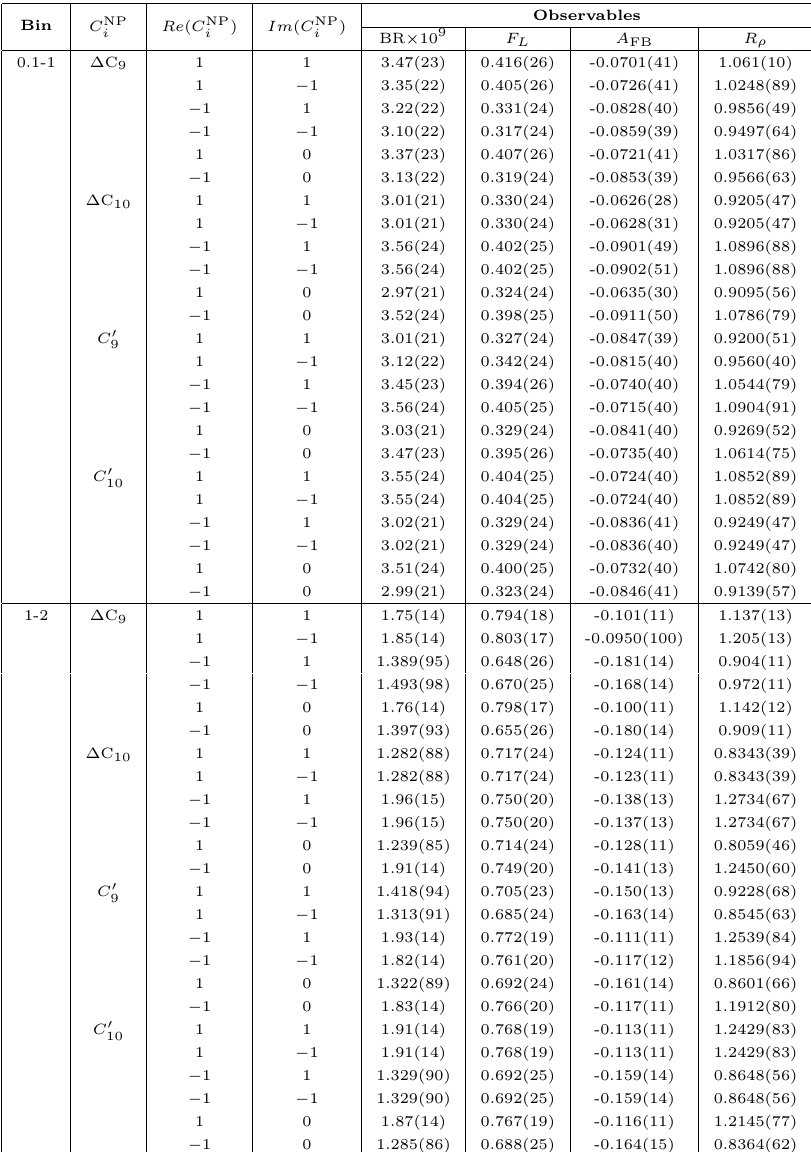
Table 26 . The dependence of the Branching Ratio and the observables F L , A FB and R ρ corre- sponding to B ± → ρ ± ll on the real and imaginary parts of the NP WC’s ∆ C q 2 bins 0 . 1 − 1 and 1 − 2 GeV 2 for a few benchmark values of the real and imaginary parts of the corresponding